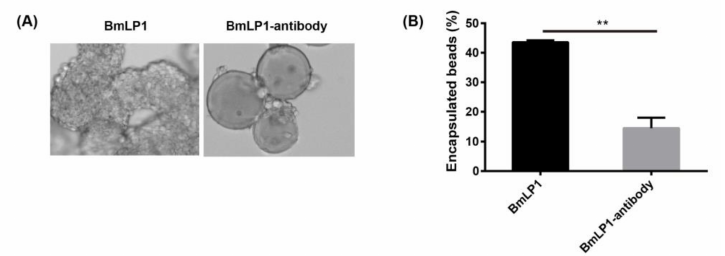
Figure 7. The encapsulation of BmLP1 was verified using BmLP1 specific polyclonal antibodies ( A ). BmLP1-coated beads were preincubated with BmLP1 specific polyclonal antibodies. Antibody-bound beads were incubated with hemocytes. Encapsulation of the antibody-bound beads was observed by microscopy after 6 h. The numbers of encapsulated beads were computed ( B ). The vertical bars represent the mean ± SE (n = 2). Student’s t -test was used to calculate statistical significance. ** p < 0.01 versus the control. The error bars indicate the standard error of the mean (n =